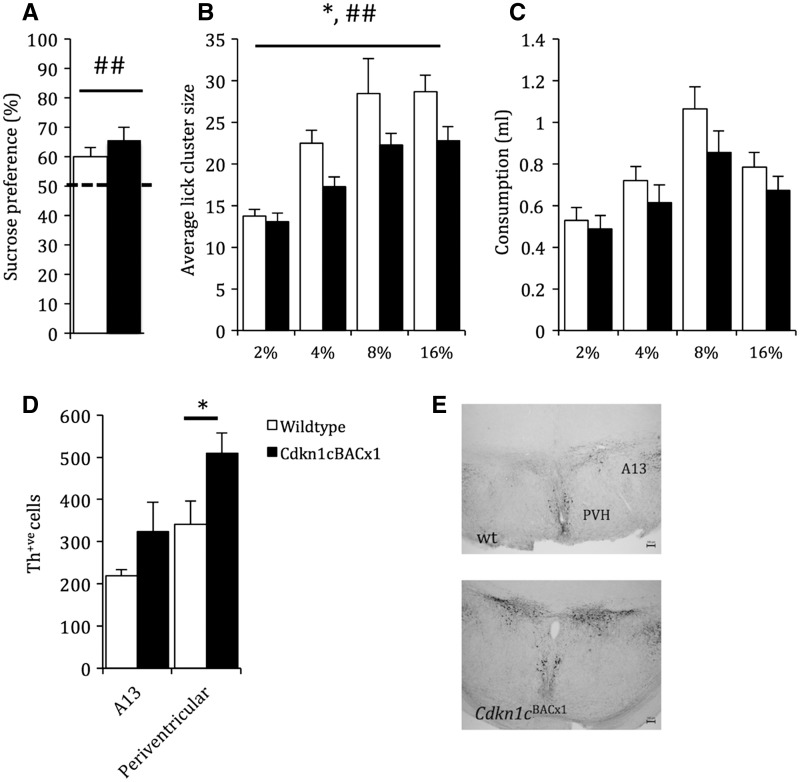
Cdkn1cBACx1 animals show a reduced perceived palatability of a sucrose solution. (A) All animals preferred sucrose to water and this was not affected by genotype. (B) Cdkn1cBACx1 animals had consistently smaller average lick cluster size compared to WT indicating altered hedonic processing. (C) Despite potentially reduced perceived palatability, consumption of a palatable solution was not different between Cdkn1cBACx1 animals and WT. (D) Cdkn1cBACx1 had significantly more Th-positive cells that wt in the periventricular hypothalamus (PVH), but not the A13 dopaminergic cell group. (E) Representative images showing Th staining. Scale bar is 100 μm. Data shown is ± SEM. Main effect of GENOTYPE, *=P ≤ 0.05; main effect of concentration ##= P < 0.01.